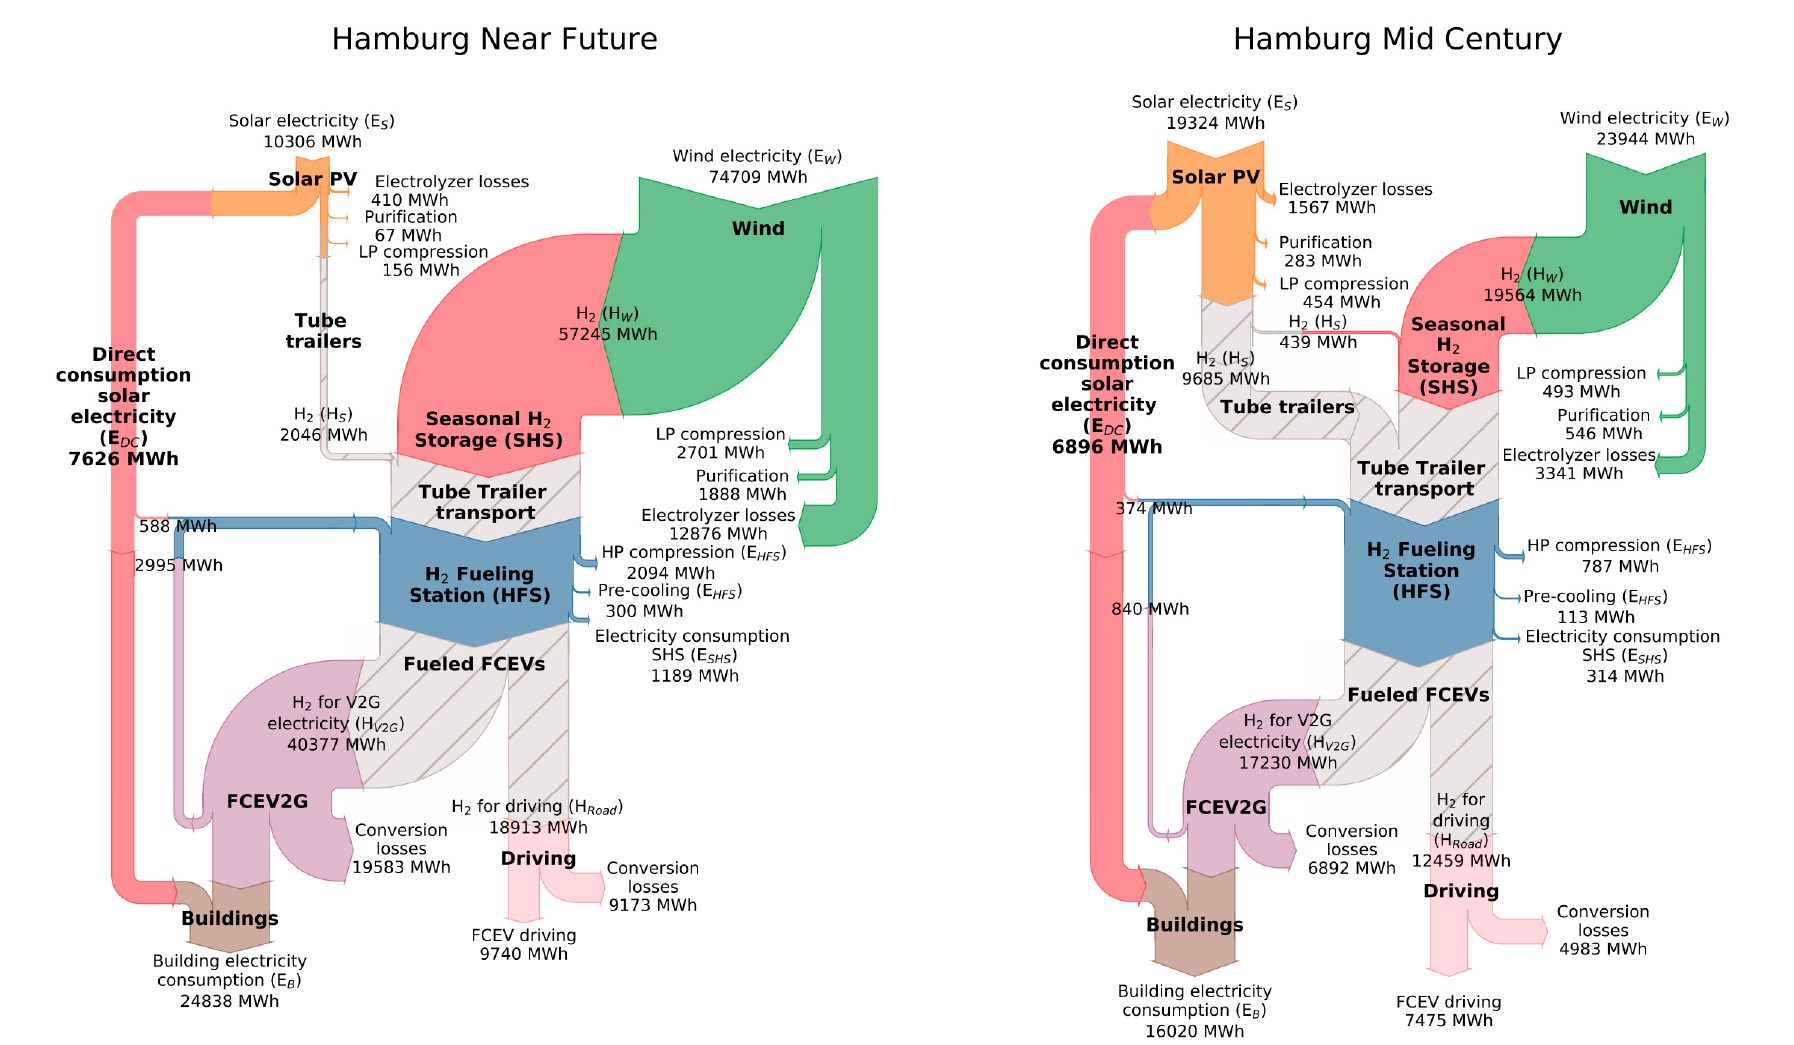
Figure 4. Annual energy balance for Hamburg for the Near Future scenario (left) and Mid Century scenario (right).